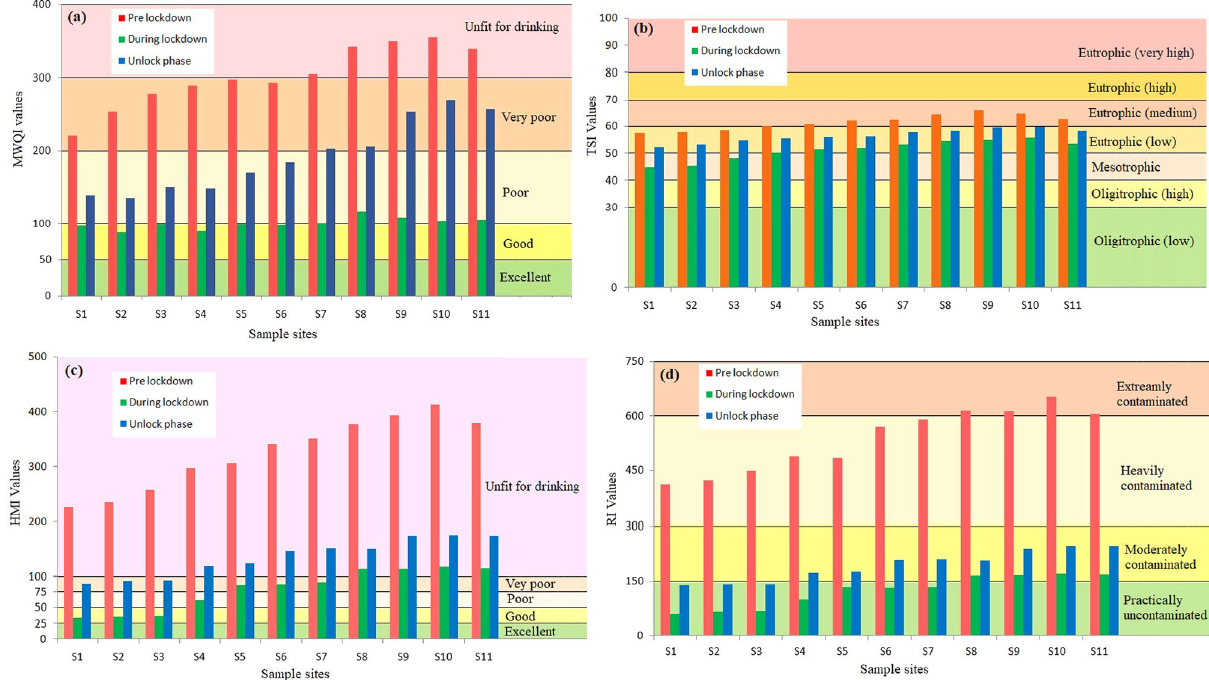
Figure 3. Spatiotemporal variation of water quality values at each sampling sites. This figure is prepared by MS office 2007 (https:// micro soft- office- 2007. en. softo nic.